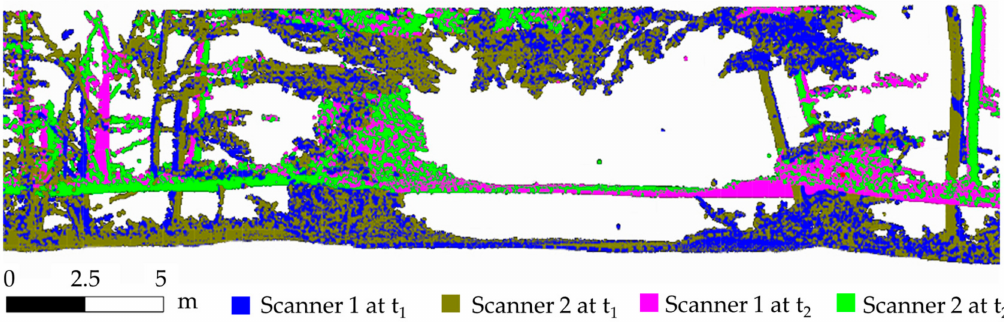
Figure 5. Cross section of two MLS records (each record has two clouds captured from Scanner 1 and Scanner 2) recorded twice with 30 min time (t 1 , t 2 )